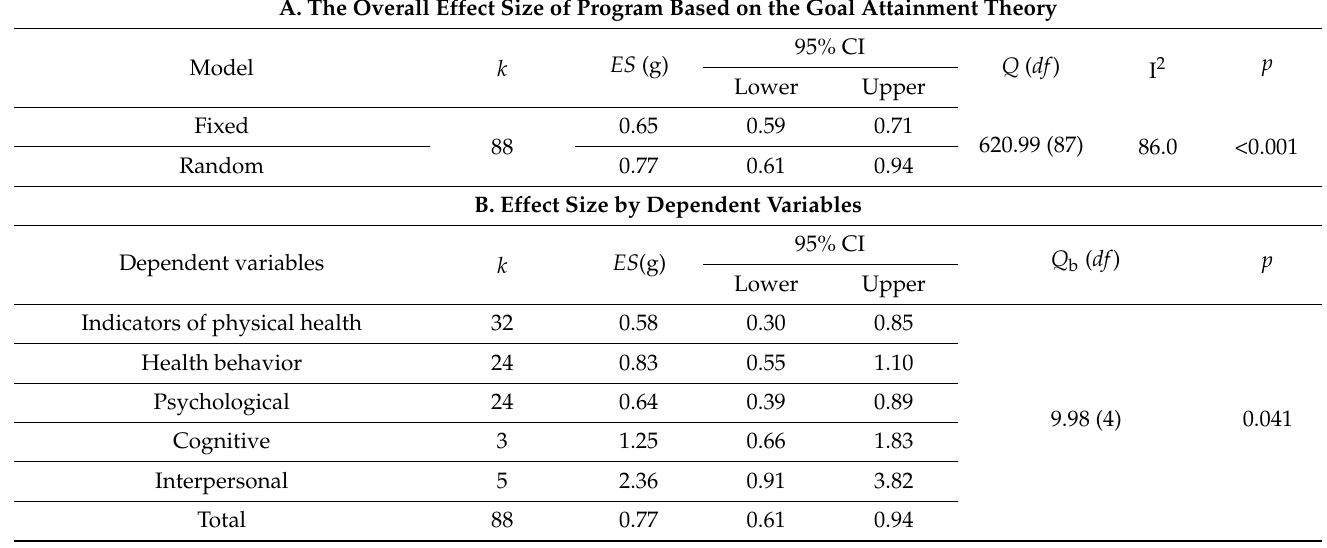
Table 2. Effect size and tendency of the variables of nurse-led program based on the goal attainment